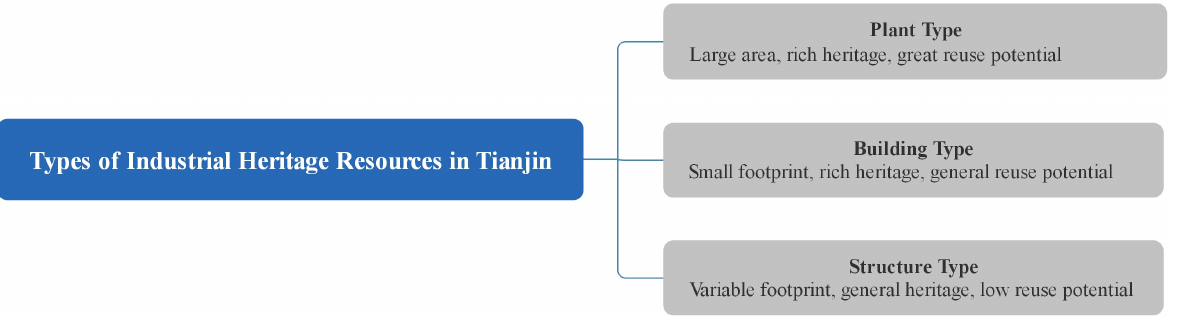
Figure 7. Resource types of industrial heritage in Tianjin and their characteristics.